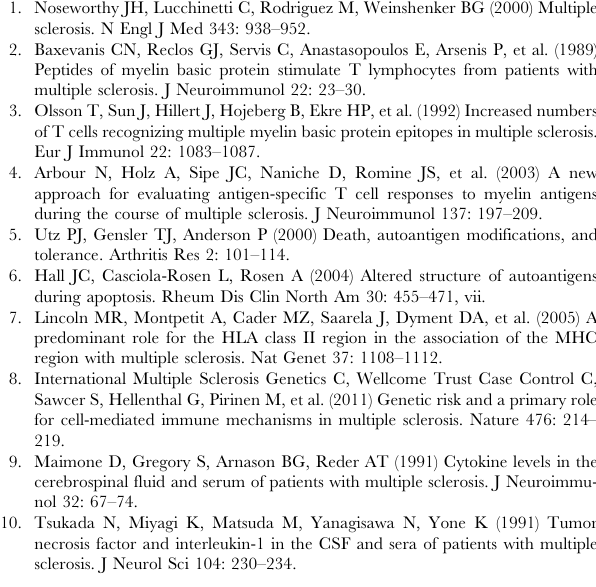
Figure S3 MFIs of peripheral and intrathecal CD8 + T cells. MFIs of TNF- a - ( A ) and IFN- c -producing ( B ) peripheral (upper panels) and intrathecal (lower panels) CD8 + T cells are shown for OIND, progressive (Prog.) and relapsing-remitting (RR) patients in response to all candidate Ag’s. *0.01 , p , 0.05, **0.001 , p , 0.01, ***p , 0.001 . (TIF) Figure S4 Daclizumab-induced changes of peripheral and intrathecal T cell reactivities. Intracellular cytokine secretion of each research subject was analyzed for IFN- c + , TNF- a + and double positive T cell events. The sums of all cytokine positive events were normalized to beads. Ratios of intrathecal to peripheral auto-Ag-specific T cell reactivities of un-treated (RR) and DAC HYP-treated RRMS patients (Dac) were calculated for CD4 + ( A ) and CD8 + T cells ( B ). Ratios greater than one (dotted line) indicate enrichment of Ag-specific T cell events in the intrathecal compartment; ratios lower than one represent less pronounced intrathecal T cell responses. Horizontal bars represent median values; vertical lines represent interquartile ranges. ( C ) CD4 + T cell reactivities to foreign Ag’s are shown for blood (upper panel) and CSF (lower panel) for the same patient cohorts described above. Box plots represent median values with 25 th and 75 th percentiles; black lines indicate minimum and maximum values. *0.01 , p , 0.05, **0.001 , p , 0.01, ***p , 0.001 .